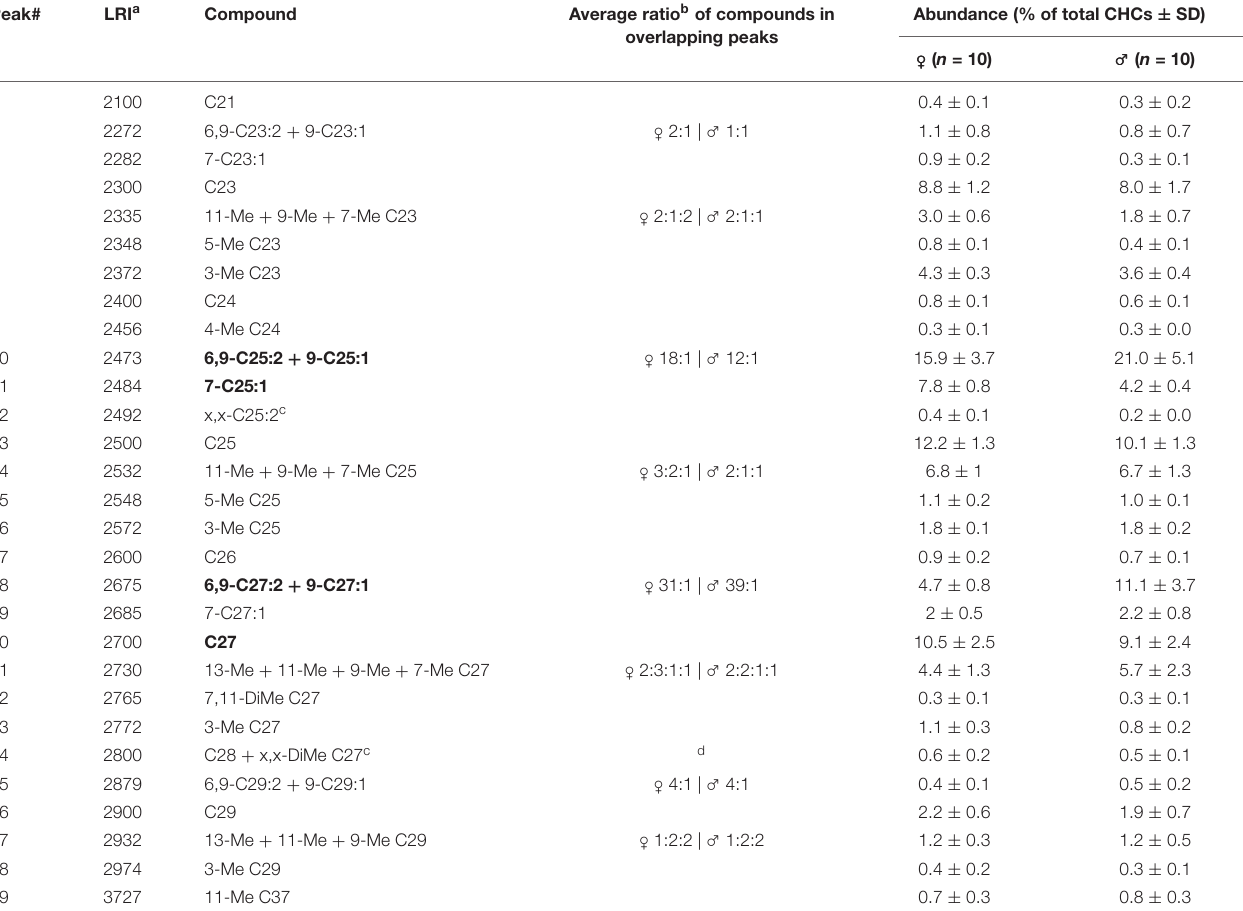
TABLE 1 | Cuticular hydrocarbons (CHCs, > 0.25% relative amount of total profile) found in crude extracts of male and female Tachinaephagus zealandicus